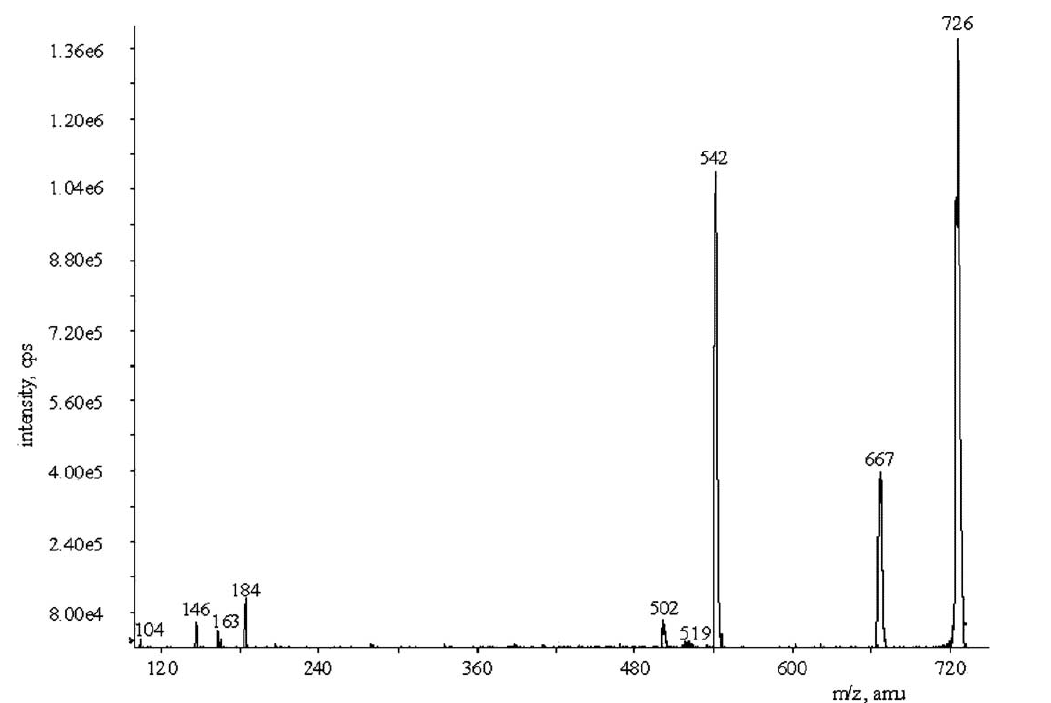
FIG. 5. Positive ion electrospray MS/MS spectrum of the ion at